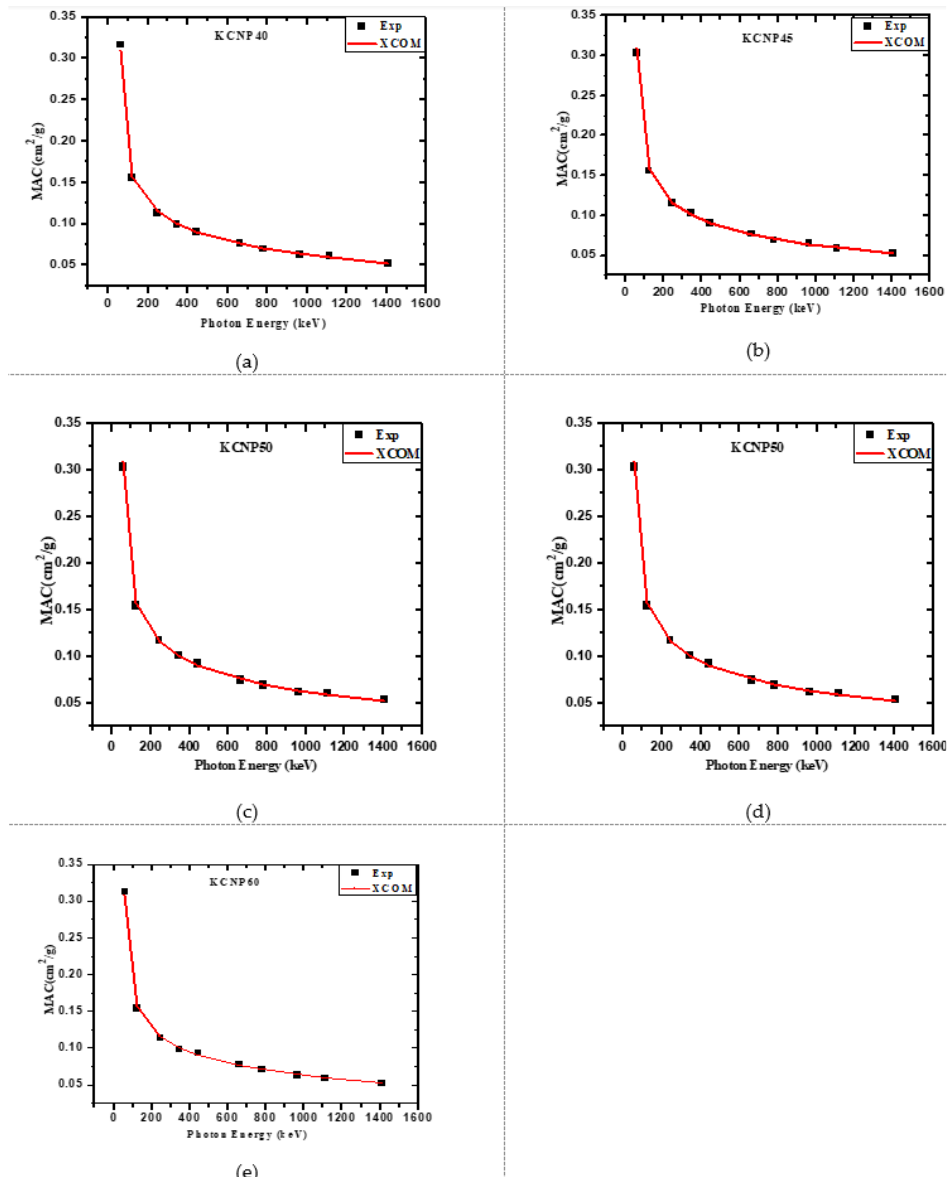
Figure 2. The comparison between the MAC obtained by experimental method and calculated by XCOM (all these are one figure). ( a ) CKNP40; ( b ) CKNP45; ( c ) CKNP50; ( d ) CKNP55; ( e ) CKNP60. Table 1. The measured mass attenuation coefficient and XCOM results for the fabricated glasses.